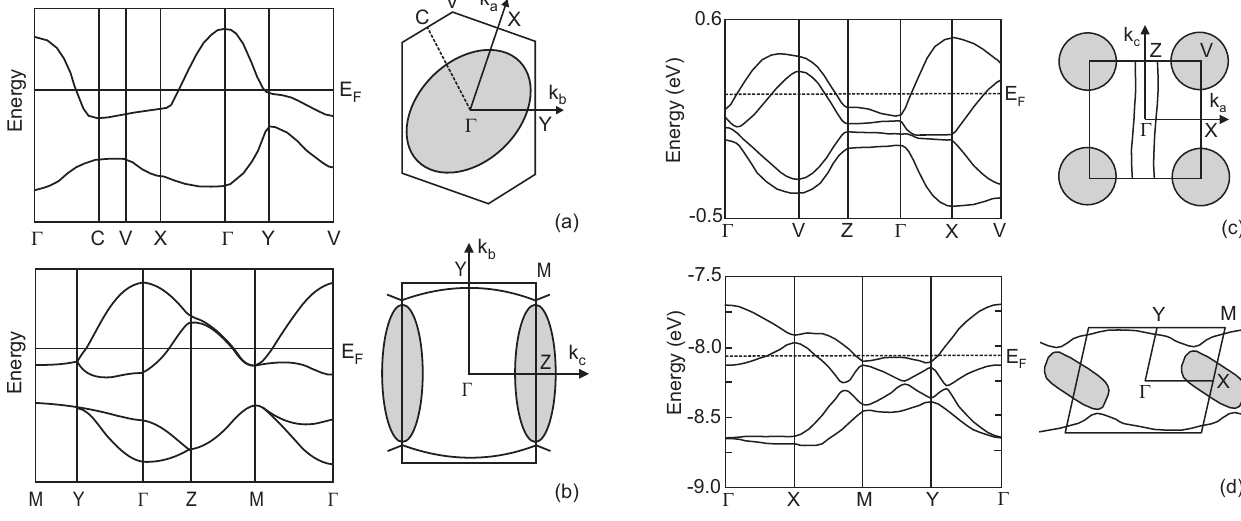
Figure 2. Calculated band structures and Fermi surfaces for ( a ) (cid:12) -phase (after Reference [18]), ( b ) (cid:20) -phase [21,22], ( c ) (cid:11) -phase [23], and ( d ) (cid:12) ′′ -phase BEDT-TTF salts